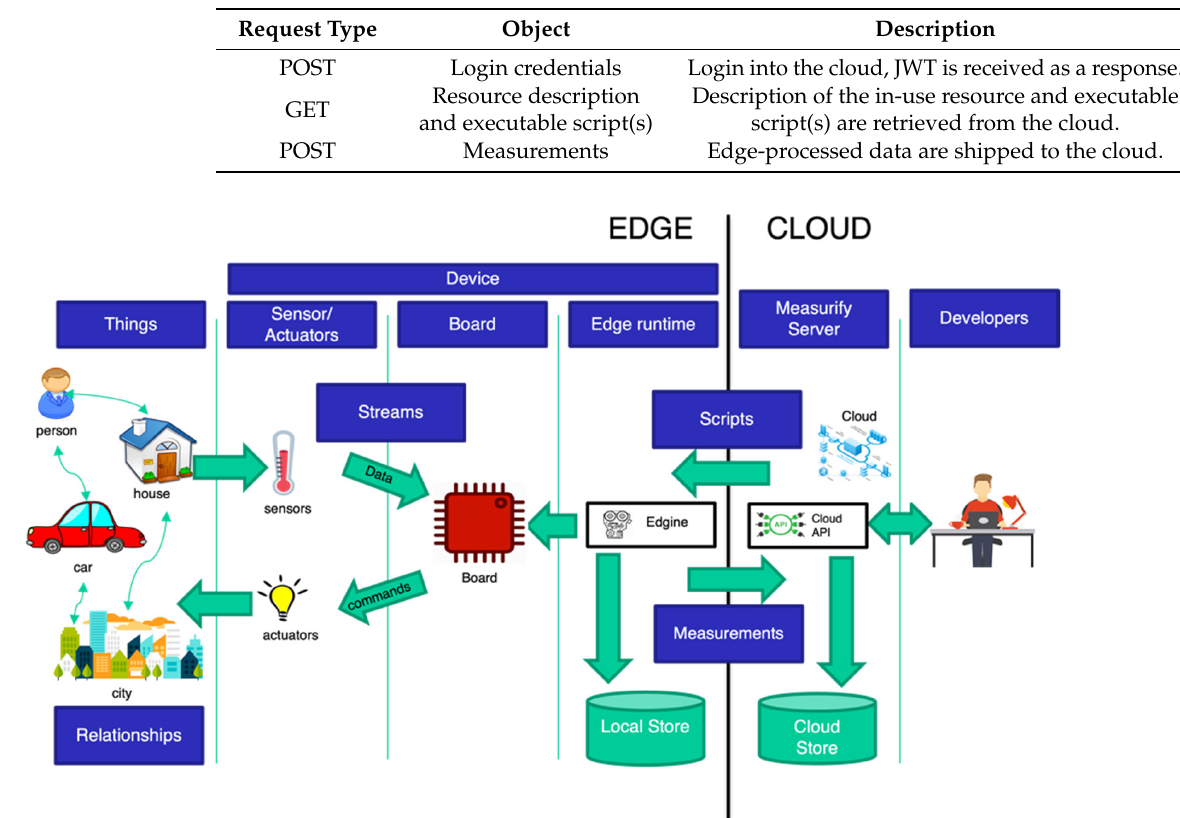
Figure 3. Edgine–Measurify overall end-to-end system architecture.